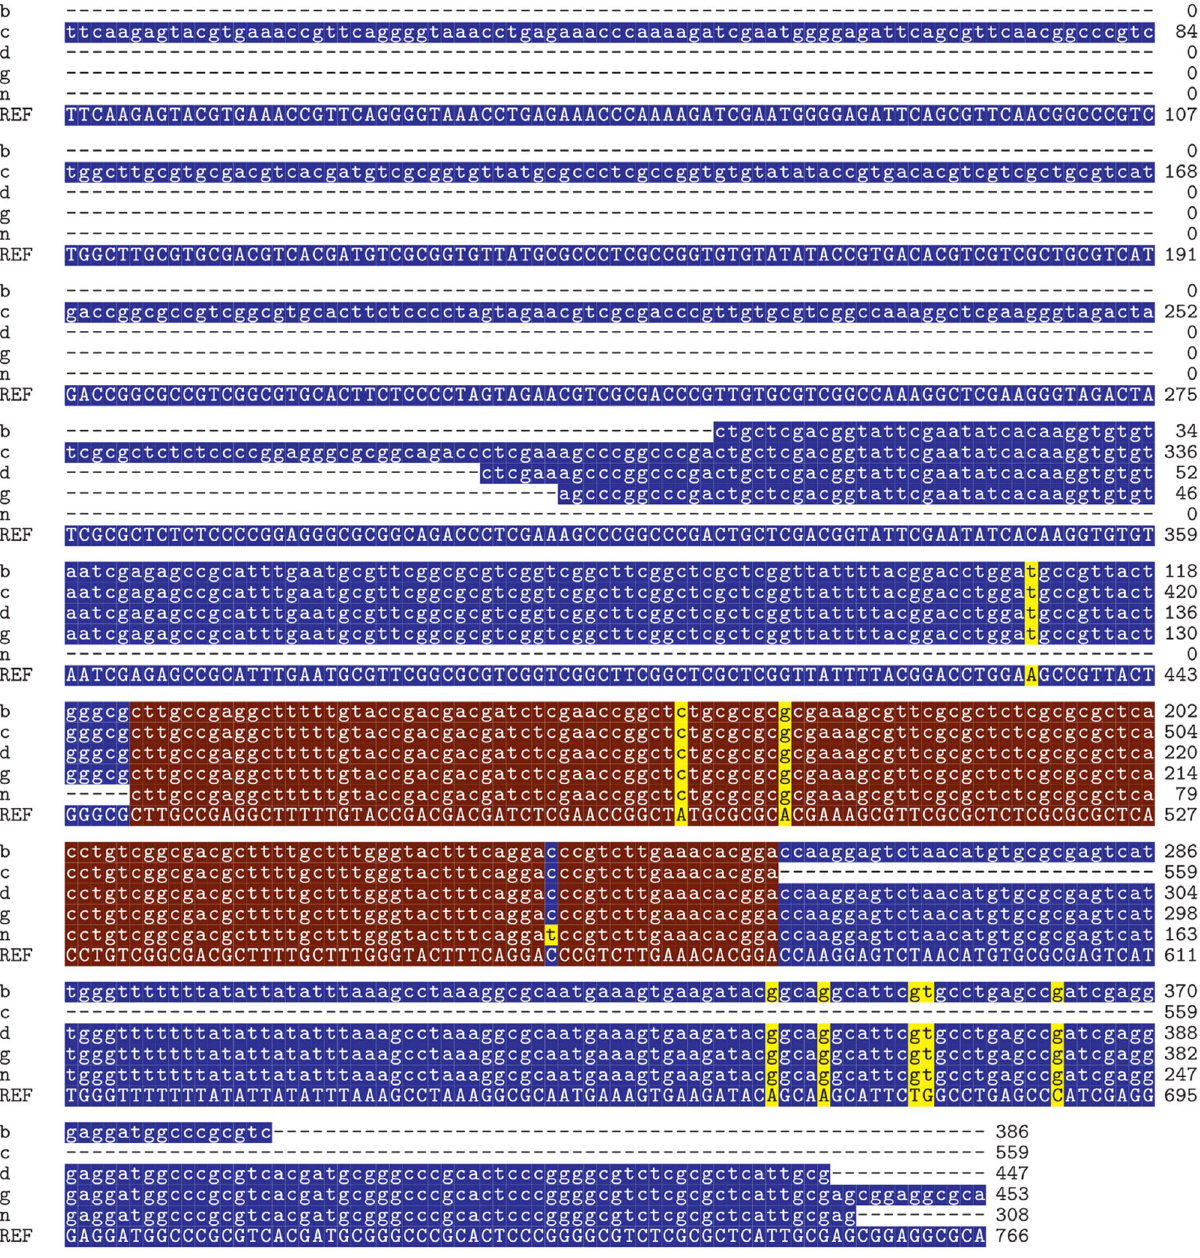
Figure 1. Multiple sequence alignments. The contigs were predicted to have I. hookeri origins based on the partial reference sequence of I. hookeri 28S ribosomal RNA gene (MH077537.1). Letters on a blue background indicate sequence identity from less than all the samples, and letters on a brown background indicate the parts where all 5 samples and the reference sequence are identical. Positions with yellow backgrounds indicate polymorphisms. The geopositions of the Hungarian samples are presented in Fig.